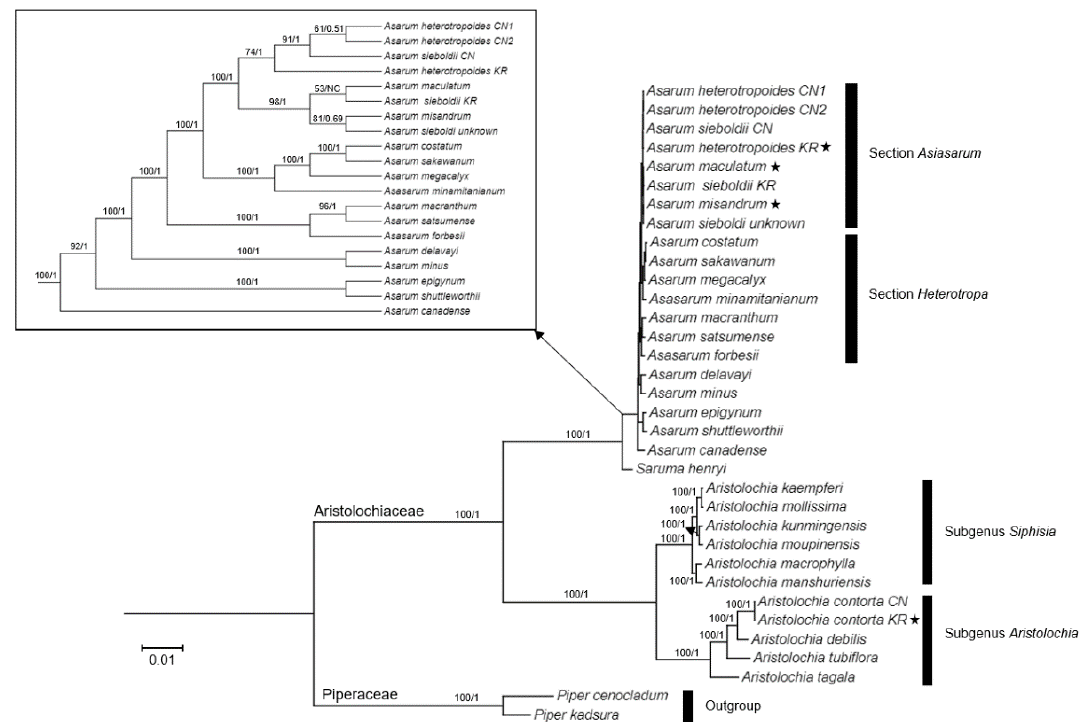
Figure 5. Maximum likelihood (ML) analysis of Aristolochiaceae based on 79 plastid protein-coding genes. The first and second number on each node indicate the bootstrap value of ML and posterior probability of Bayesian inference, respectively. The NC means “Not calculated”. Newly sequenced individuals in this study are marked with a star. A cladogram of Asarum species was presented in the box to show their relationships. CN and KR next to taxon name indicate Chinese and Korean accession, respectively.